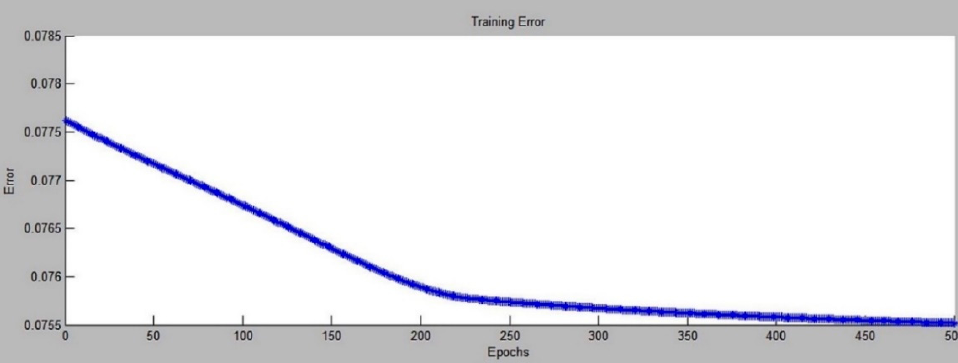
Figure 5. Training error.